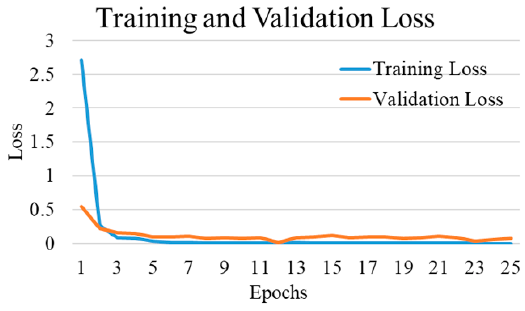
Figure 27. Training and validation loss of best performing VGG16 model for Faces95 images.